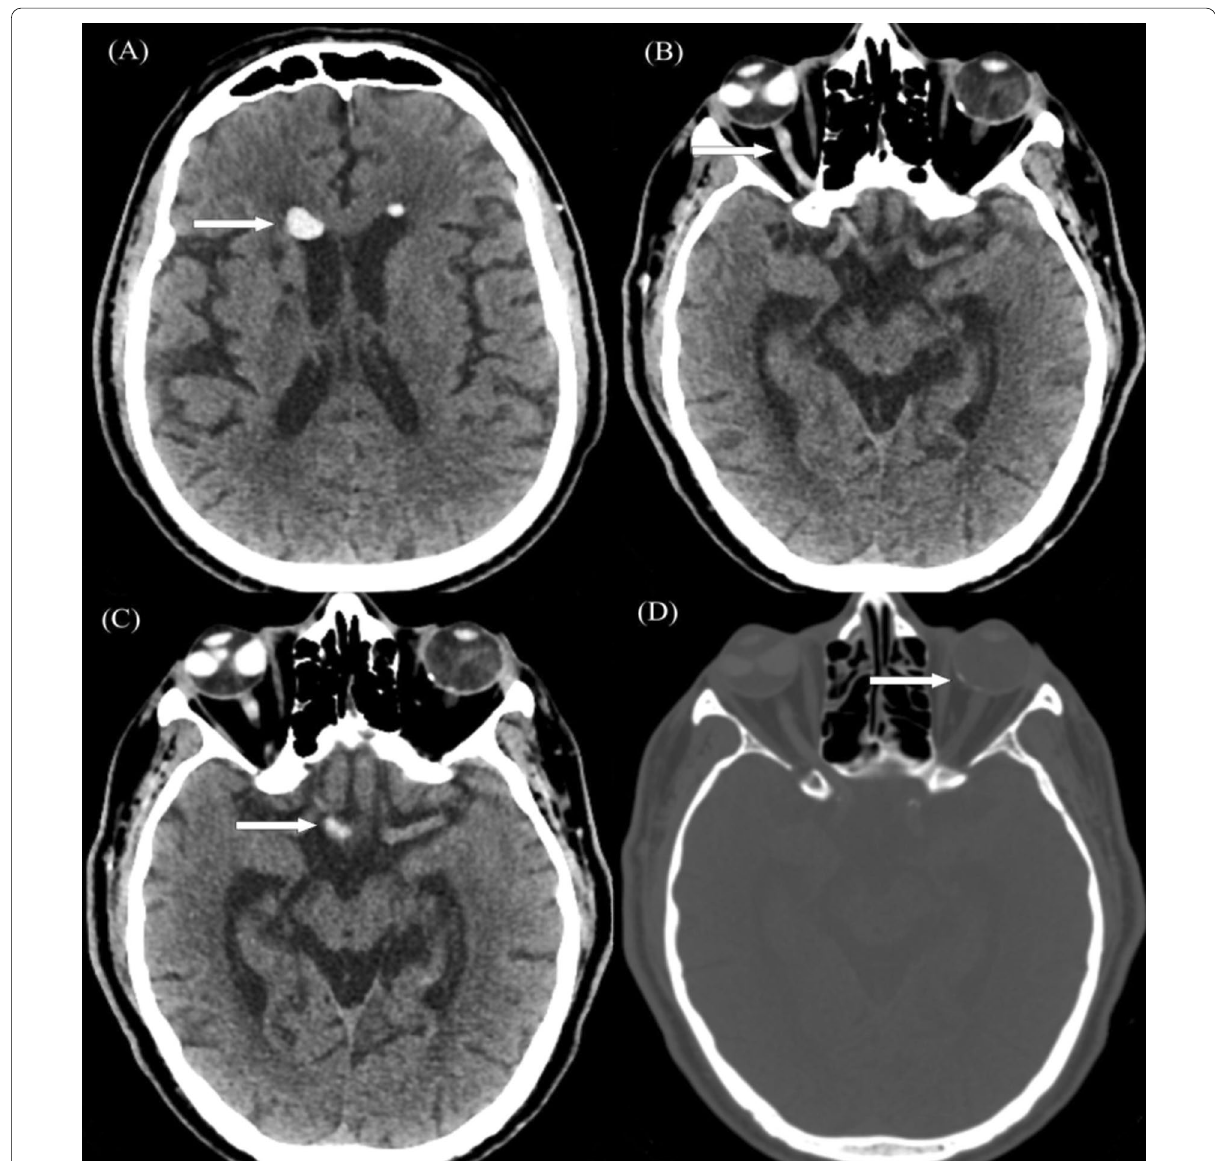
Fig. 1 NCCT axial sections of the head show multiple hyperdense foci (arrows)— A Globular hyperdense lesions (average HU of 80) in frontal horns of bilateral lateral ventricles. Also, note the small hypodensities in the right gangliocapsular region suggestive of chronic lacunar infarcts. B Hyperdense globules within the vitreous chamber of the right globe and linear hyperdensity along the right optic nerve. C The linear hyperdensity is noted extending up to the right side of the optic chiasma. D Bone window shows small scleral calcifications in the left